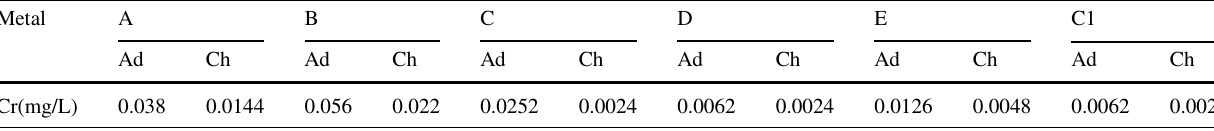
Table 7 Carcinogenic risks due to Cr